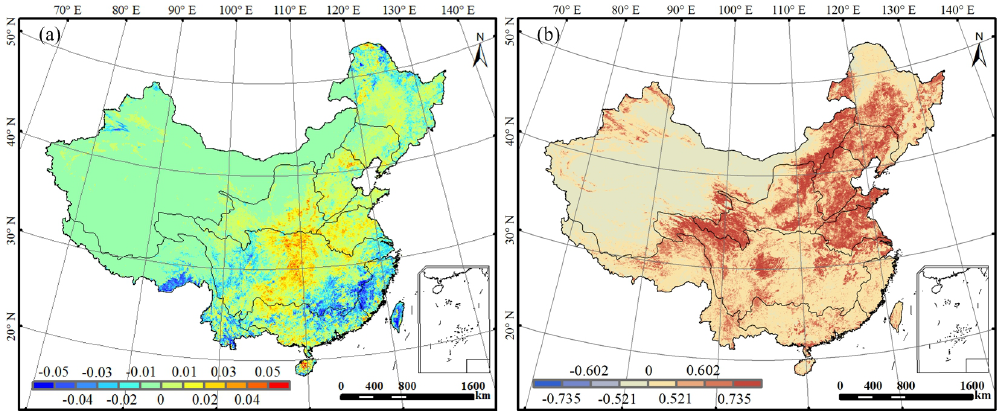
Fig. 14. (a) Temporal trends of LAI and (b) the correlation coefficients of annual LAI with annual ET from 2000 to 2010. Correlation coefficients of 0.521, 0.602, and 0.735 indicate respective significance levels of 0.10, 0.05, and